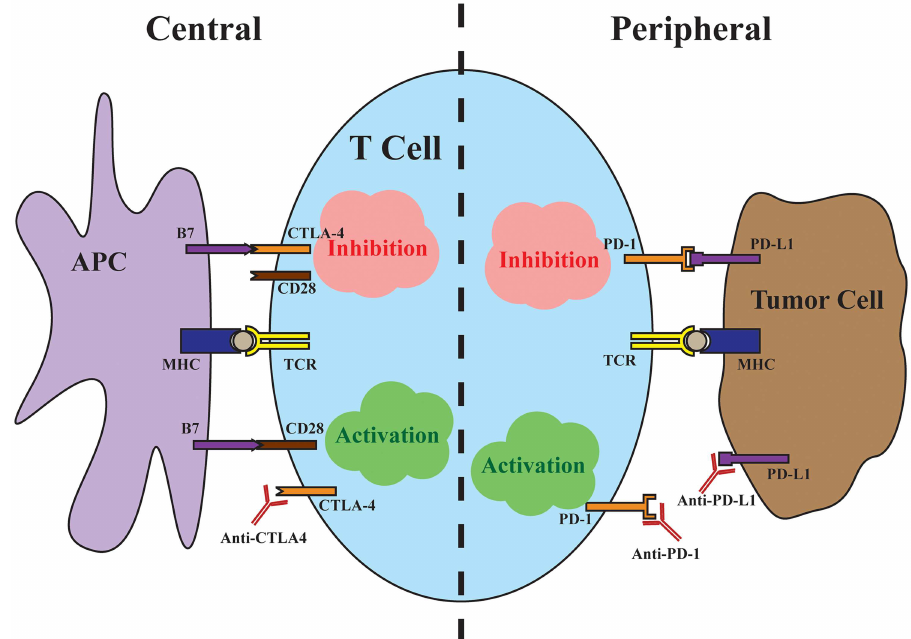
Fig 1. Central and peripheral immune checkpoints. Centralimmune inhibitionoccurs as a result of CTLA- 4 bindingto the costimulatory B7 ligandsfound on antigen-presentingcells (APCs) with high affinity, preventing signalingthrough CD28. Antibodiestargeting CTLA-4 release this checkpointto allowT cell activation. Peripheral immune inhibitionoccurs through bindingof the PD-L1 found on tumor cells to the PD-1 receptoron T cells. Antibodiestargeting either the ligandor the receptorrelease this